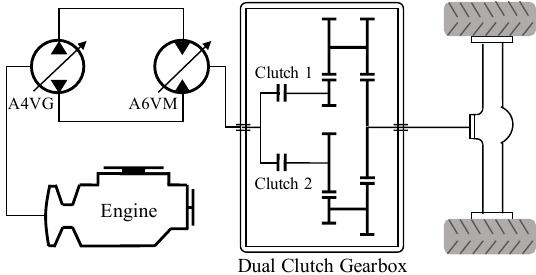
Figure 1. HST+DCT